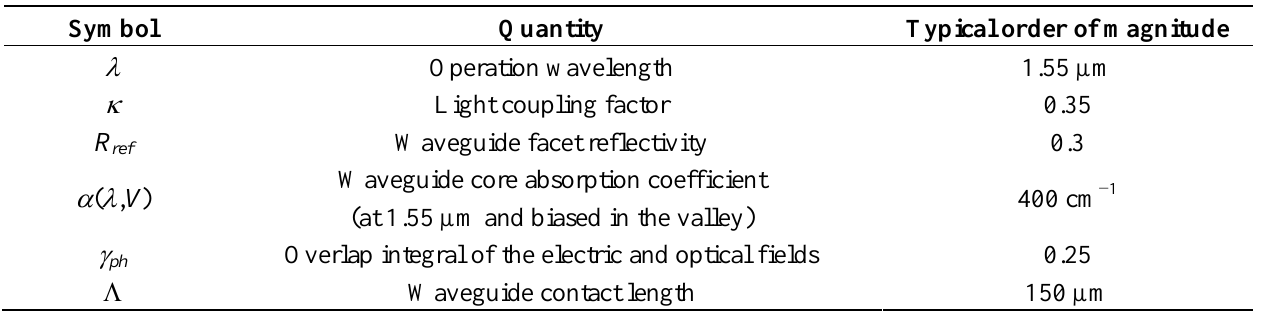
Table 1. Description of the typical physical parameters of the waveguide photo-detector.